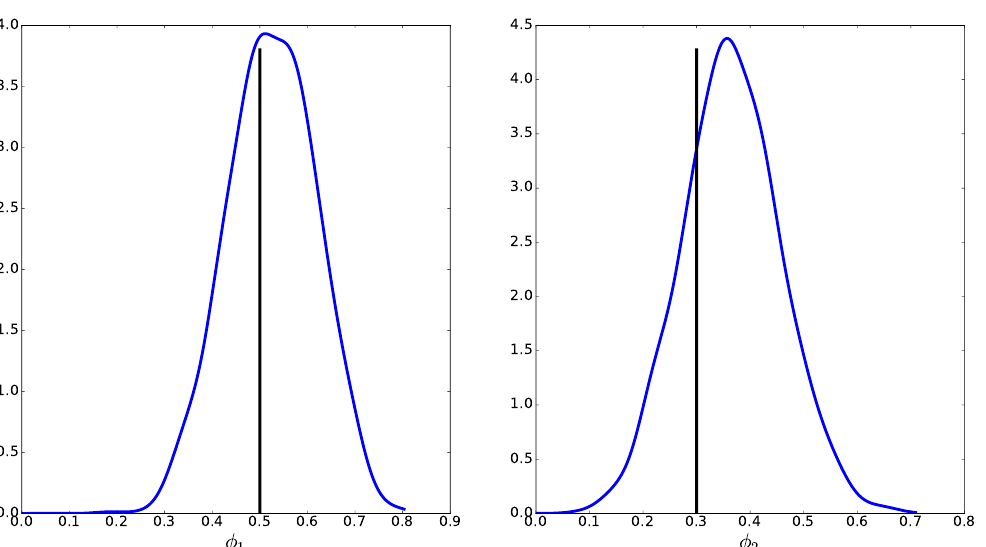
Figure 3. Markov chain for φ 1 and φ 2 .